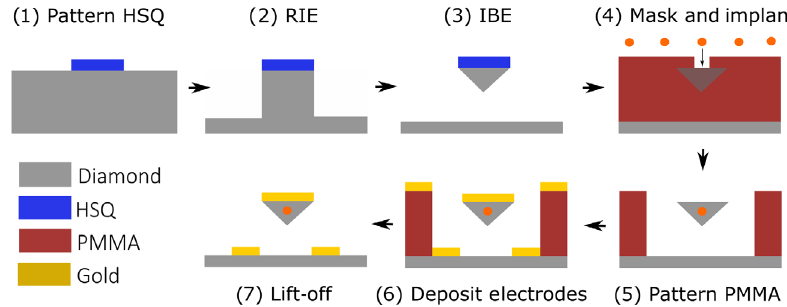
FIG. 5. Schematic of nanofabrication process. Diamond waveguides are fabricated using top-down and angled etching technique into the diamond substrate [22,23,31]. This was followed by patterning apertures on top of the fabricated structures through which Si þ ions can reach the diamond substrate at desired locations [21]. Finally, we deposit gold electrodes on top of and below the diamond devices [11,32], which serve to deflect fabricated waveguides when a voltage is applied between